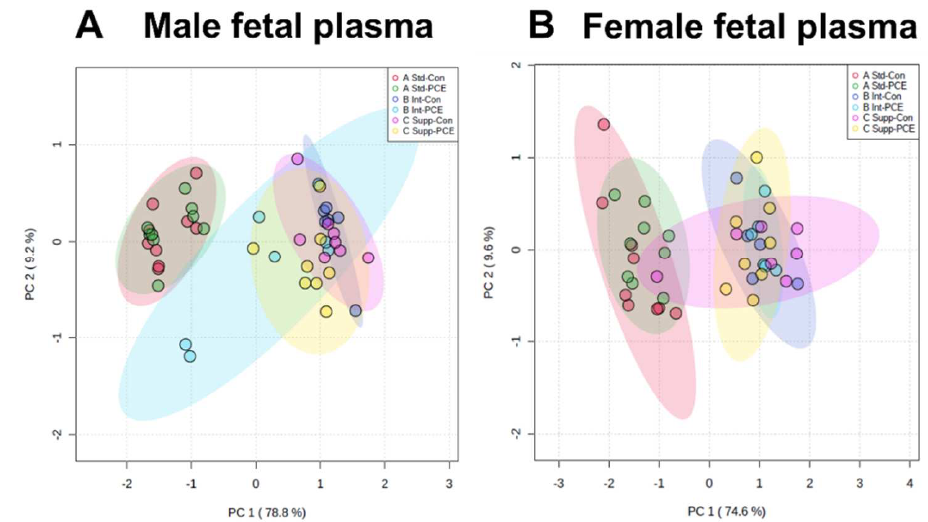
Figure 6. The effects of periconceptional ethanol and choline supplementation on the one-carbon metabolism (1CM) pathway in late-gestation fetal plasma. Principal components analysis (PCA) of 10 molecules from the 1CM pathway across the 6 experimental groups in fetal plasma of ( A ) males and ( B ) females. Molecules were measured using mass spectrometry. Standard chow (1.6 choline/kg chow, Std) with control (0% EtOH, Con) liquid diet (Std-Con, red); Std with periconceptional ethanol (12.5% v / v EtOH, PCE) liquid diet (Std-PCE, green); intermediate chow (2.6 g choline/kg chow, Int) with Con (Int-Con, dark blue); Int with PCE (Int-PCE, light blue); supplemented chow (7.2 g choline/kg chow, Supp) with Con (Supp-Con, pink); Supp with PCE (Supp-PCE,